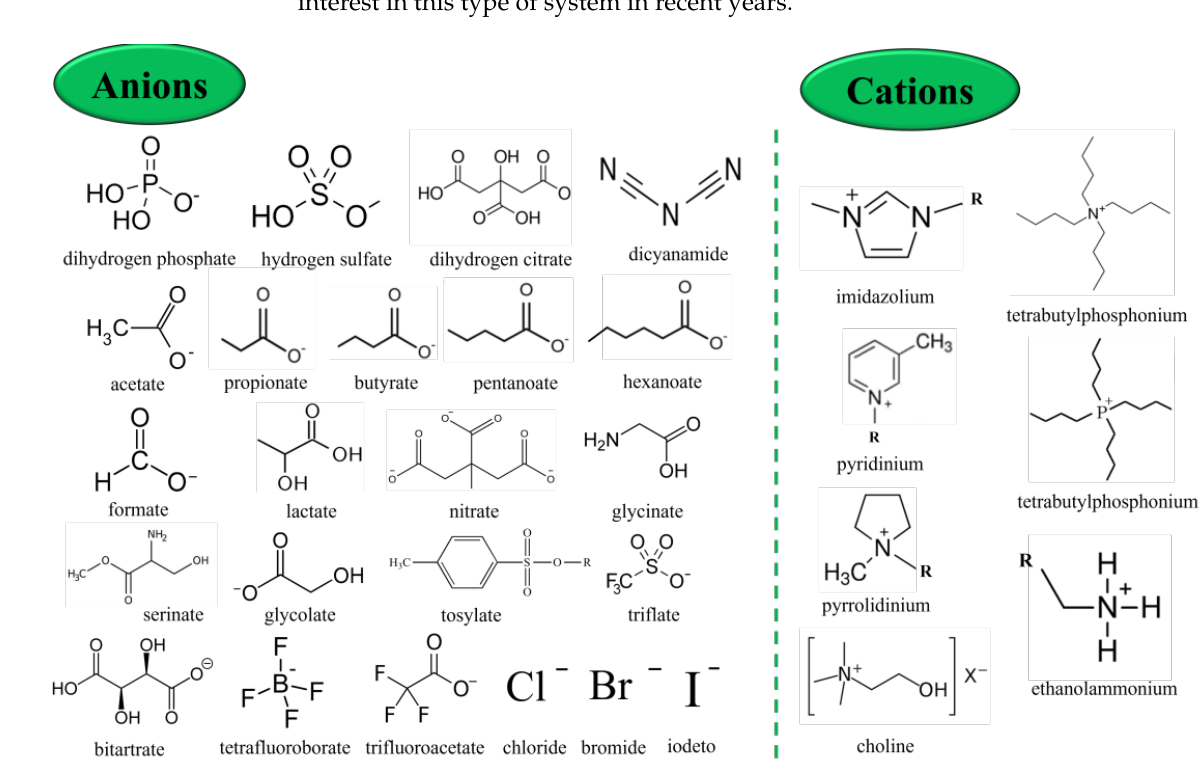
Figure 2. Structures of anions and cations that can be combined to form IL.